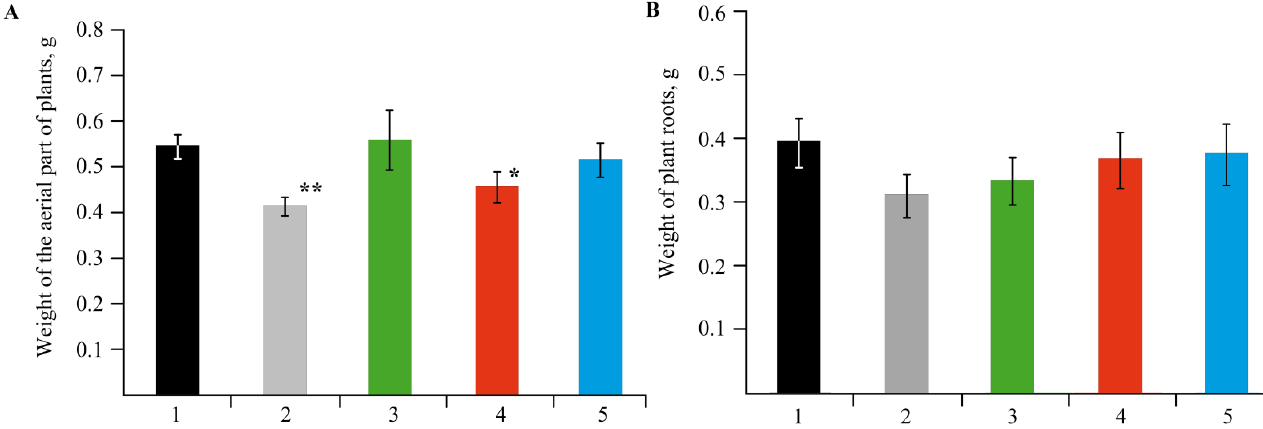
Figure 8. Mass of the vegetation of plants ( A ) and the biomass of roots ( B ) in the control medium and in plants grown in a nutrient medium with NCs; (1)—control, (2)—without Mn sulfate in medium, (3)—AG-Mn, (4)—AGS-Mn, (5)— κ -CG-Mn; * p ≤ 0.05 and ** p ≤ 0.01 compared to the control according to the Mann–Whitney test.